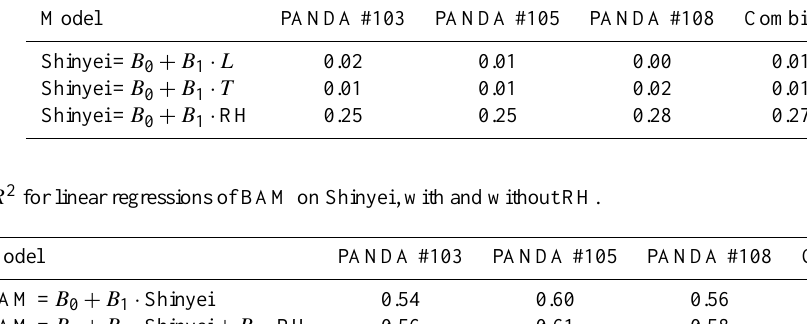
Table 1b. Adjusted R 2 for linear regressions of Shinyei PPD42NS (% full scale) on covariates. Model